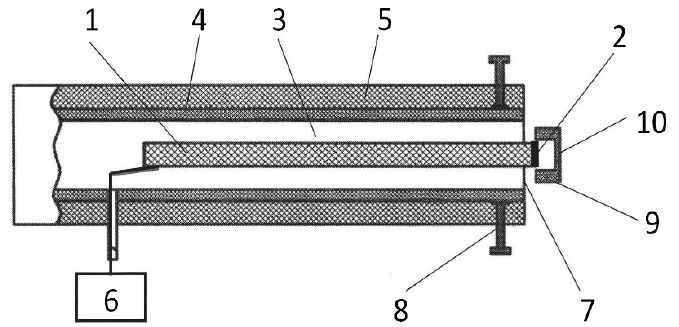
Figure 9. Scheme of the CAP generator output device: 1—piezotransformer, 2—discharge electrode, 3—ionization chamber, 4—dielectric tube, 5—hard case, 6—voltage generator, 7—output end of the dielectric tube, 8—device for changing the shape of the output end of the tube, 9—dielectric cap, and 10—dielectric layer.